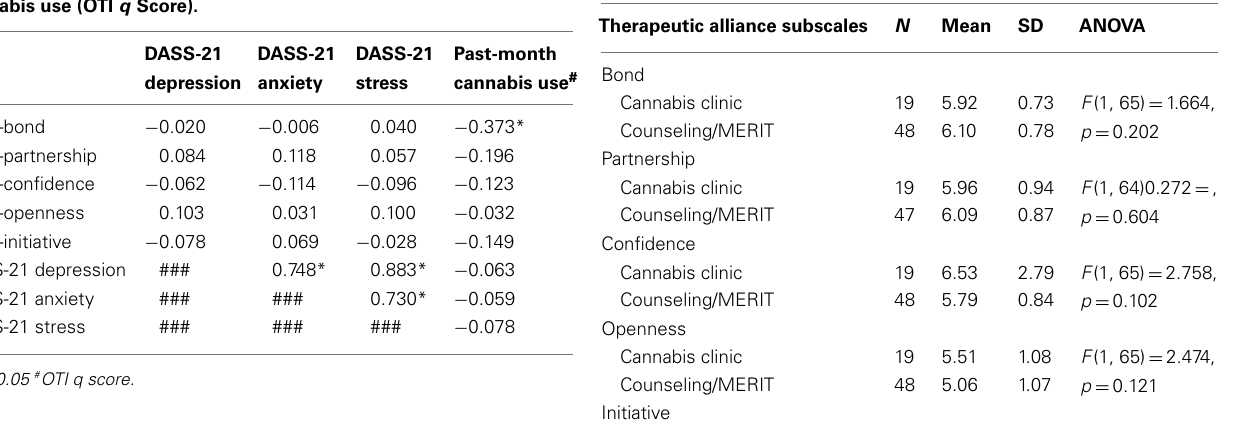
Table 3 | “Cannabis Clinic” group compared to other teams (Counseling and MERIT) # on the client-rated subscales of the Agnew-Davies Relationship Measure of therapeutic alliance.